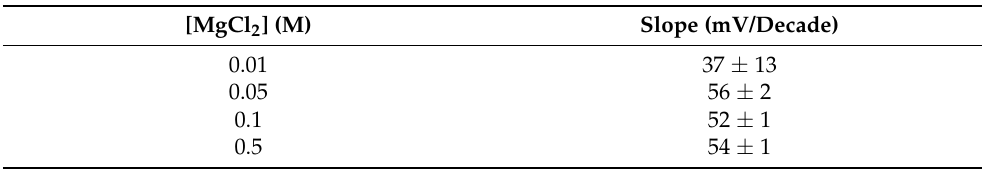
Table 4. Linear regressions obtained for lithium detection in standard solutions containing different concentrations of the supporting electrolyte (n = 5).